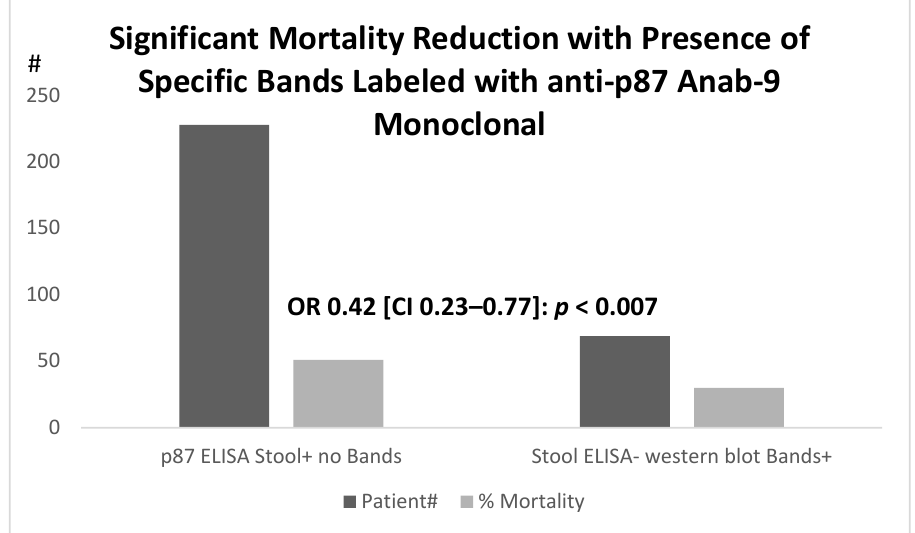
Figure 11. Relationship of outcomes in patients with positive fecal p87 ELISA (p87 ELISA stool+) and those with negative stool ELISA but detectable p87 bands in stool (Bands+).